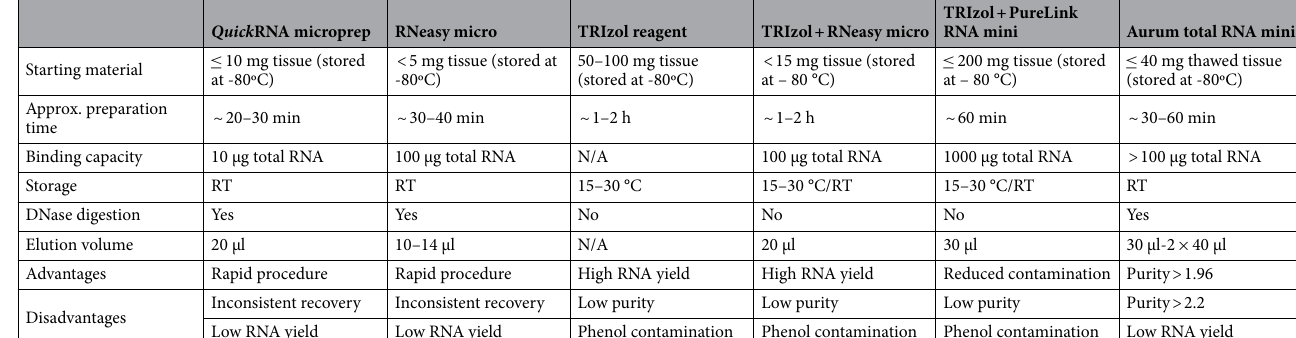
Table 2. An overview of the specifications of the evaluated commercial kits and